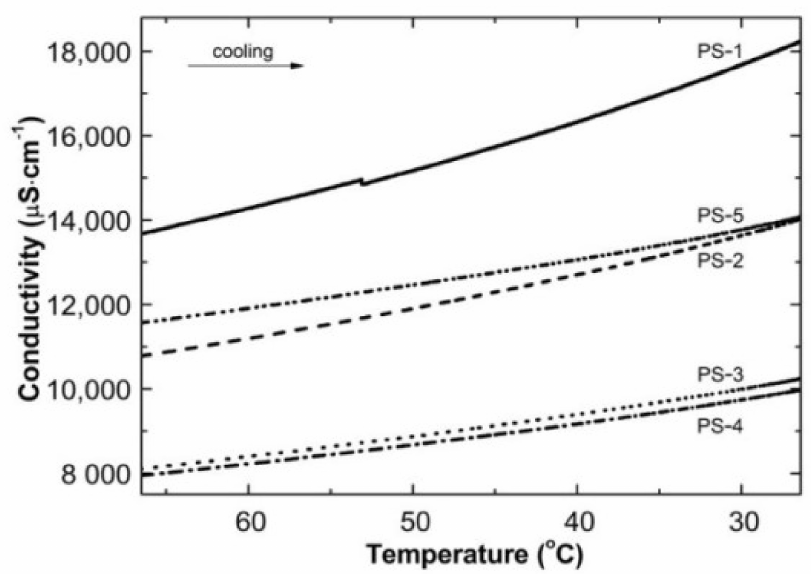
Figure 3. The changes of conductivity vs. temperature in the post-reaction mixtures of PS1–PS5 over cooling procedure.